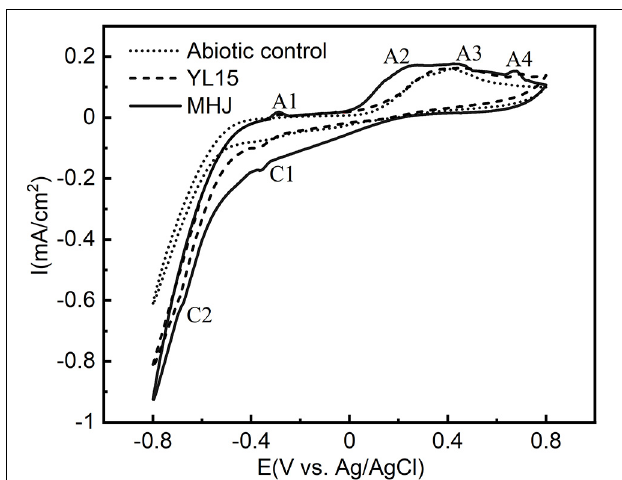
FIGURE 5 | Cyclic voltammograms of chalcopyrite electrodes in different